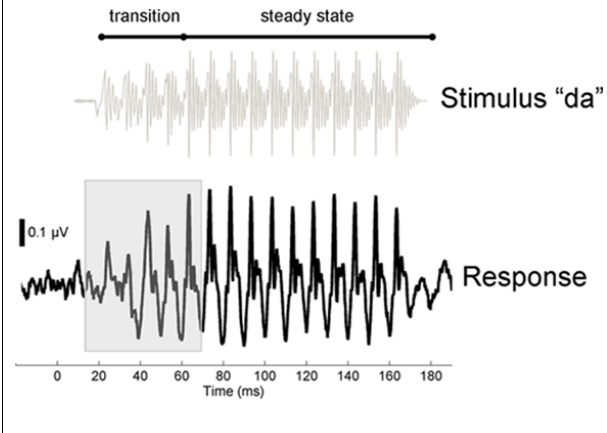
FIGURE 1 | Stimulus and response time-domain waveforms. To illustrate the temporal characteristics of the stimulus and auditory brainstem response, the baseline grand average response (average of trained and control group) is plotted below the waveform for the stimulus [da], which was presented in a noisy background of multi-talker babble.The speech stimulus is divided acoustically into a transition region, during which the speech formants change linearly as the sound moves from the consonant to the vowel, and a steady-state vocalic portion of the stimulus, where the spectrotemporal profile of the stimulus is stable. Compared to the steady-state region, the formant transition region is more strongly masked by the presence of noise.The response to the spectrotemporally dynamic transition is highlighted (10–70 ms).We compared the stimulus and the response by calculating the time lag, for each subject, at which the two waveforms align more closely. For the grand average waveform plotted here, the maximum correlation is achieved at a lag of 7.9 ms. Consequently, for this graph the stimulus waveform was shifted by 7.9 ms to the right to maximize the visual alignment with the